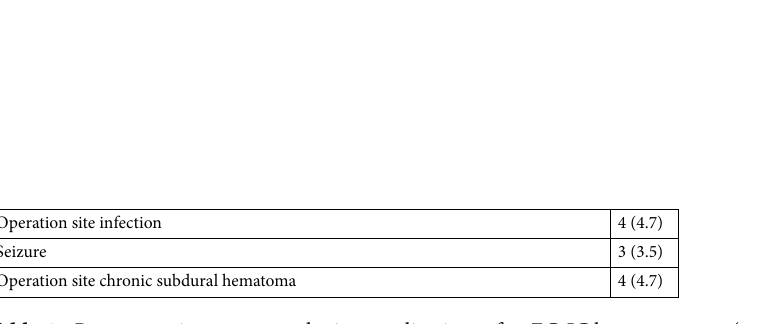
Table 4. Post-operative non-neurologic complications after EC-IC bypass surgery (number (%)). EC-IC, extracranial-to-intracranial; TIA, transient ischemic